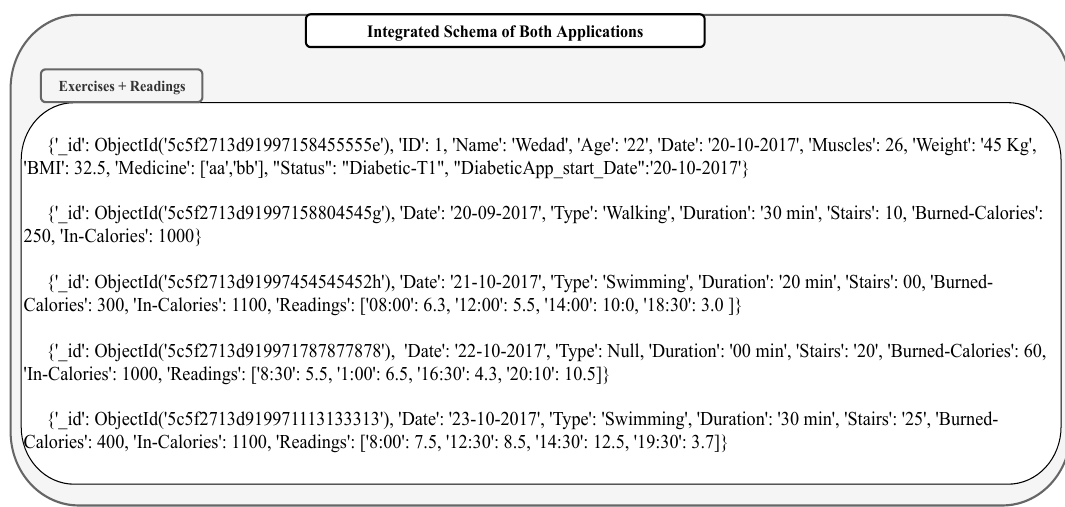
Figure 11. Applying Top-down Model for Integrating Diabetic and Exercise Applications.